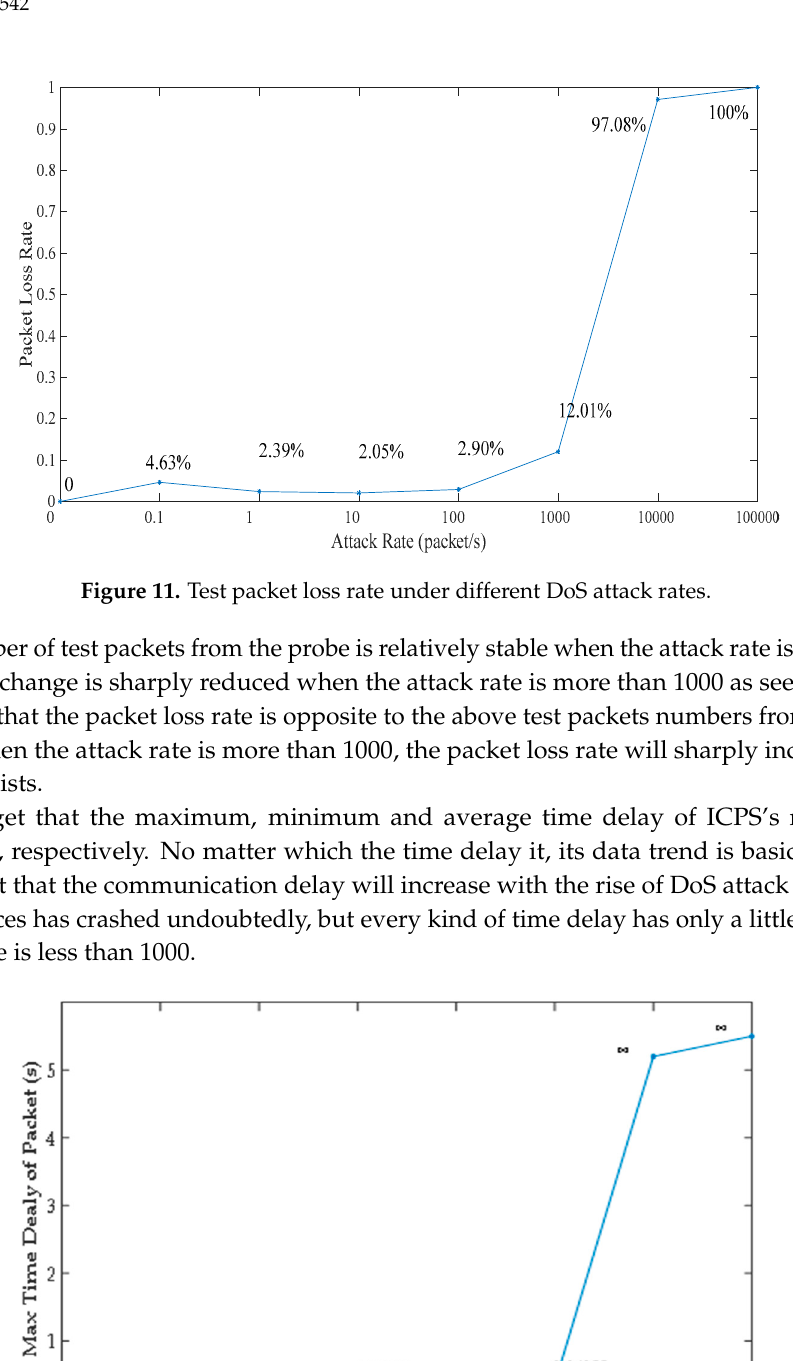
Figure 10. Test packet number per-second under different DoS attack rates.